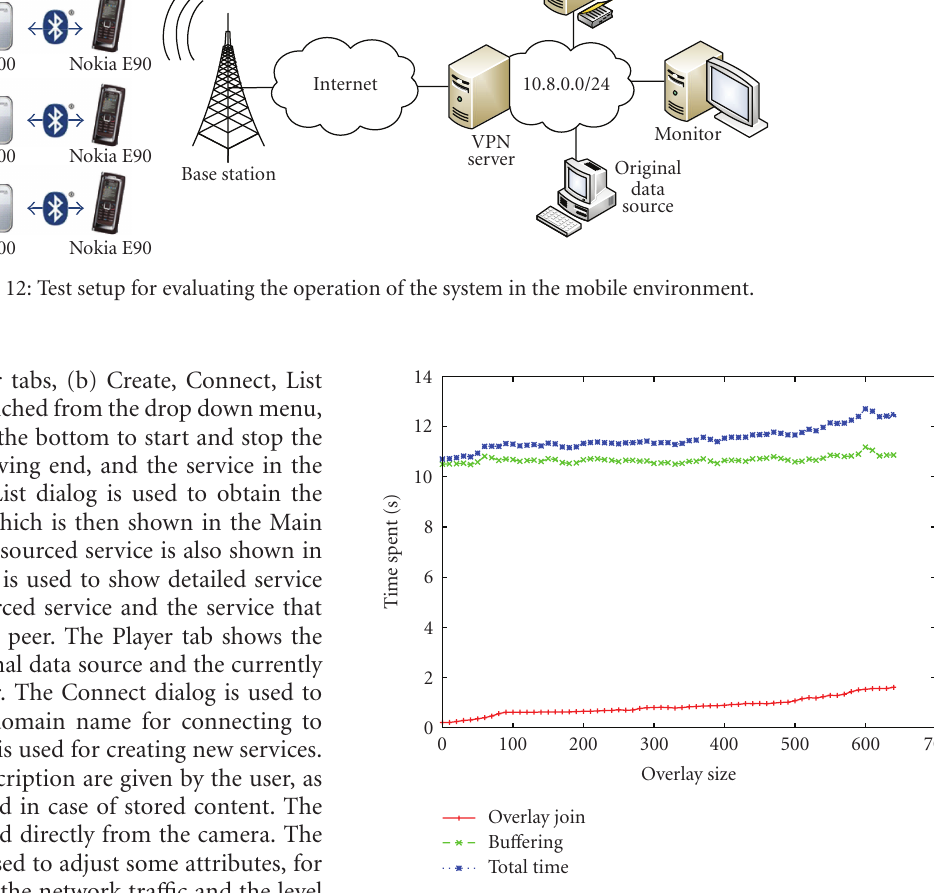
Figure 13: Overlay joining time and an initial bu ff ering time as a function of overlay size; maximum cluster size 30